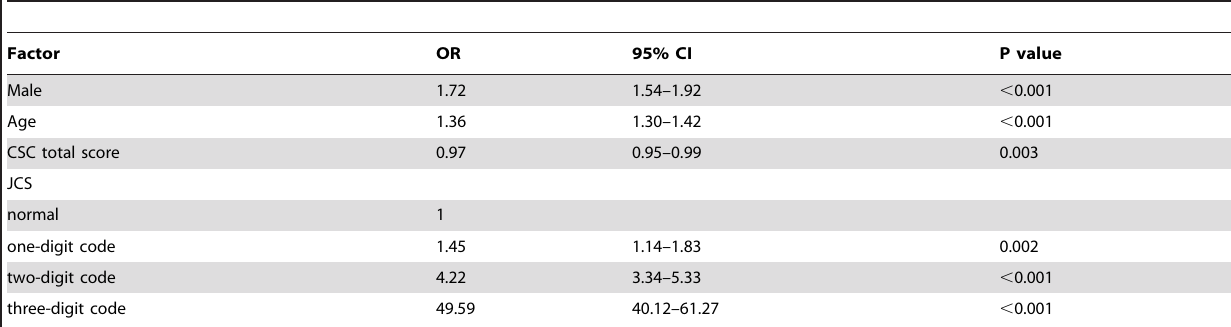
Table 5. The impact of total comprehensive stroke care (CSC) score on in-hospital mortality after intracerebral hemorrhage, adjusted by age, sex, and level of consciousness at admission according to the Japan Coma Scale